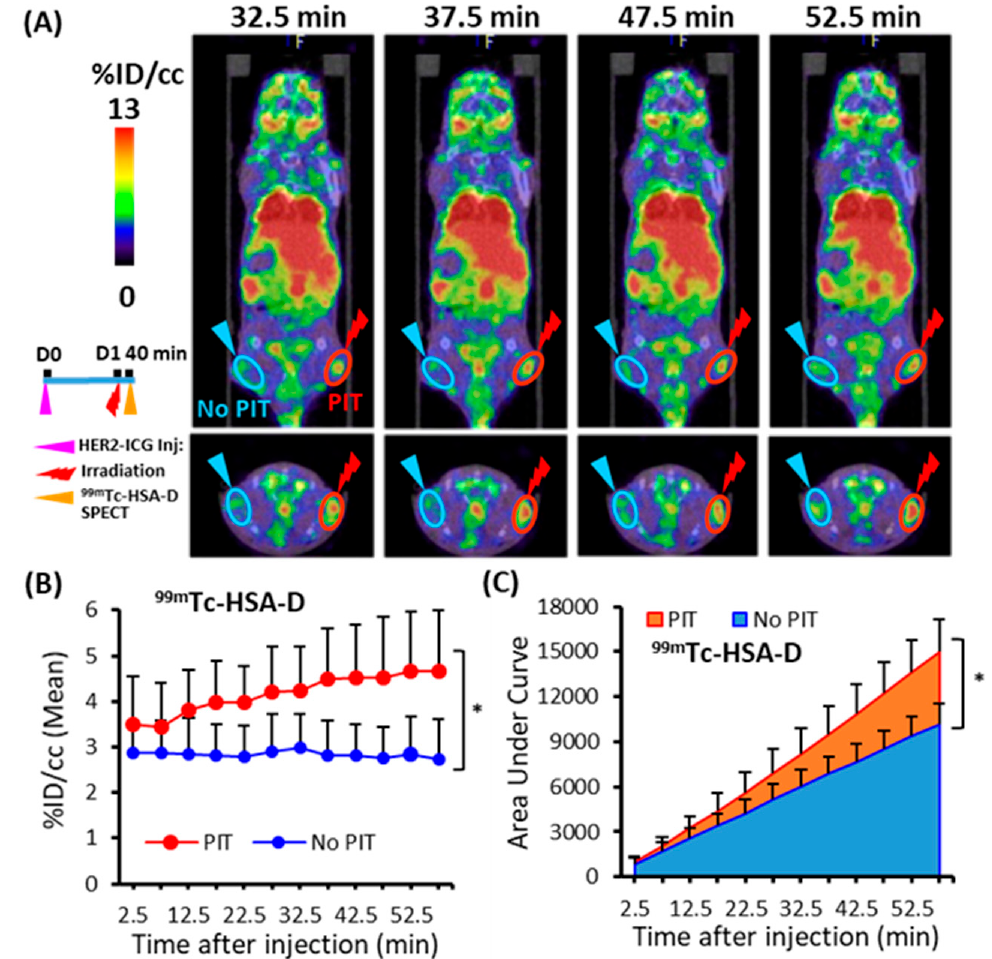
Figure 6. Dynamic SPECT/CT imaging of 99m Tc-HSA-D in tumor-bearing mice. ( A ) Representative SPECT/CT image at four time points (32.7, 37.5, 47.5, and 52.5 min) after PIT. ( B ) Time-activity curve of average accumulation of 99m Tc-HSA-D. ( C ) The summed values of the areas under the curve (AUCs) for each time point were significantly increased in PIT-treated tumors (red) compared to untreated tumors (blue). Data are presented as means ± SD ( n = 8), * p < 0.05 for PIT vs. No PIT. To demonstrate the PIT-induced SUPR effect for the non-specific large molecule probe 111 In-IgG, tumor accumulation was examined for 3 days. At various time points (3, 24, 48, and 72 h), 111 In-IgG accumulation and AUCs were comparatively higher in the PIT-treated tumors than in the untreated tumors (Figure 7). The tendency of increased accumulation of 111 In-IgG in tumors subjected to PIT was noted, although a statistically significant difference was not observed (Table